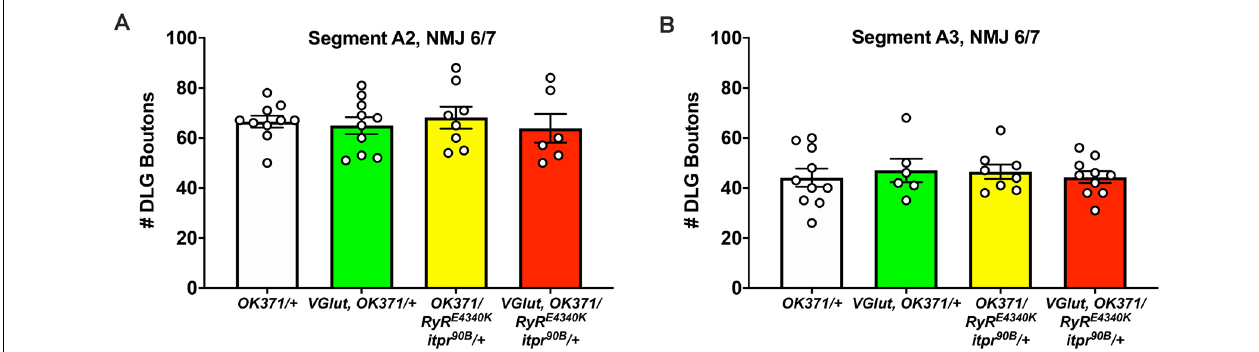
FIGURE 4 | No discernible NMJ growth defects. NMJs of third instar larvae (same genotypes as Figure 3 ) were analyzed by immunostaining, co-staining with anti-DLG for the postsynaptic density and anti-Brp to check for apposed presynaptic active zones. (A) DLG boutons counted for Segment A2, NMJ 6/7. (B) DLG boutons counted for Segment A3, NMJ 6/7. No significant differences were found across genotypes ( p > 0.9 for every possible head-to-head comparison, one-way ANOVA).